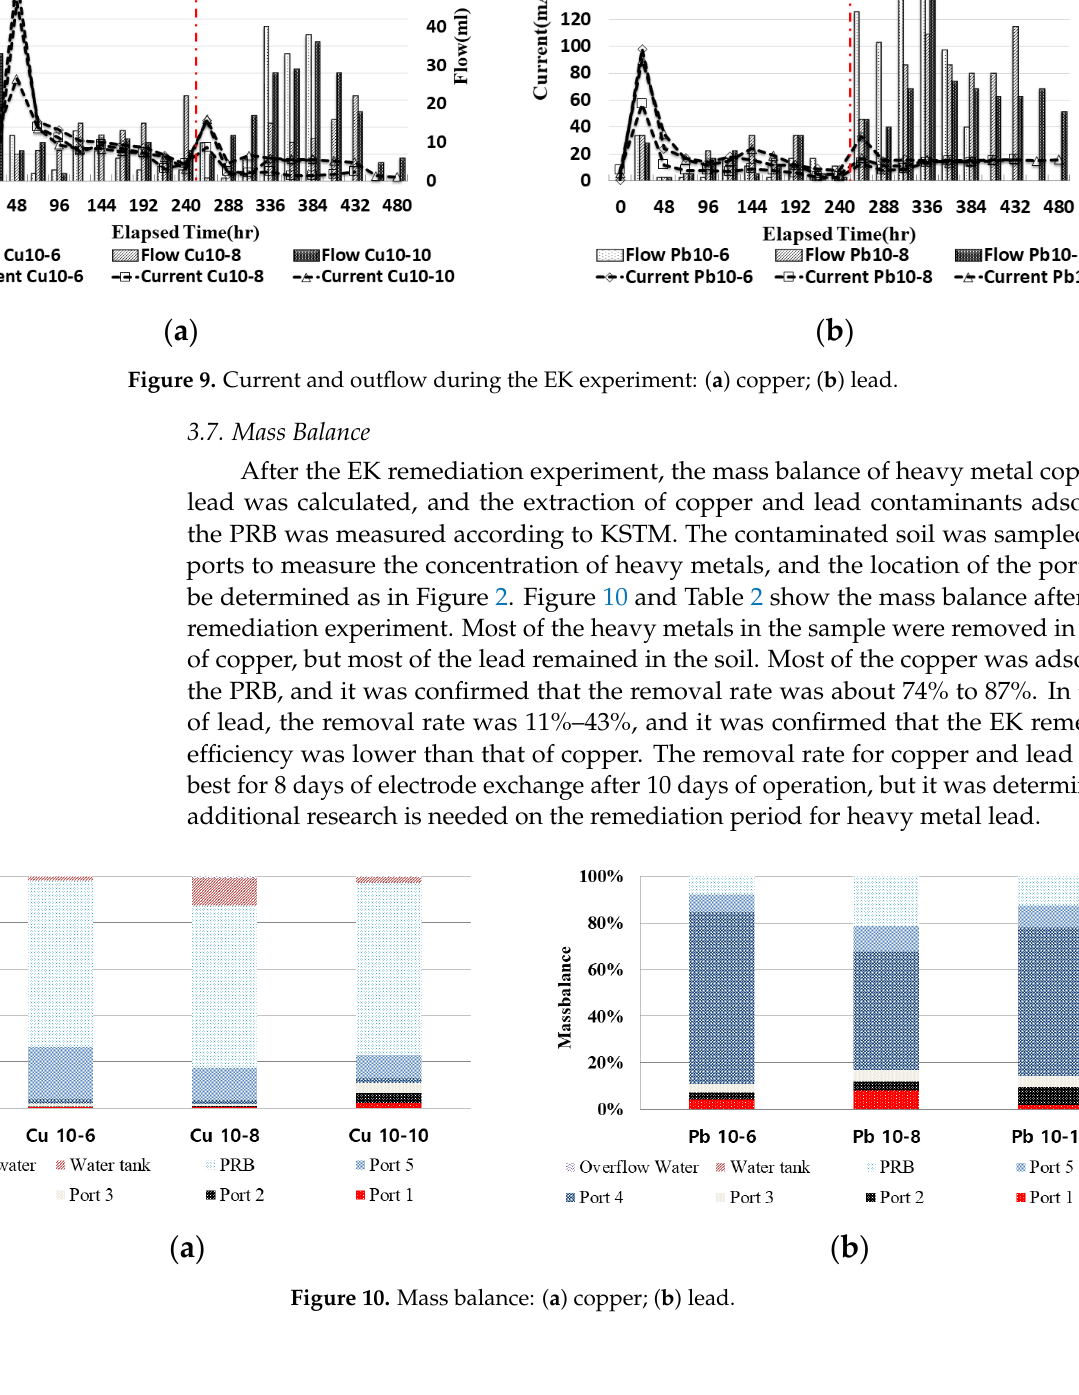
Figure 9. Current and outflow during the EK experiment: ( a ) copper; ( b ) lead.